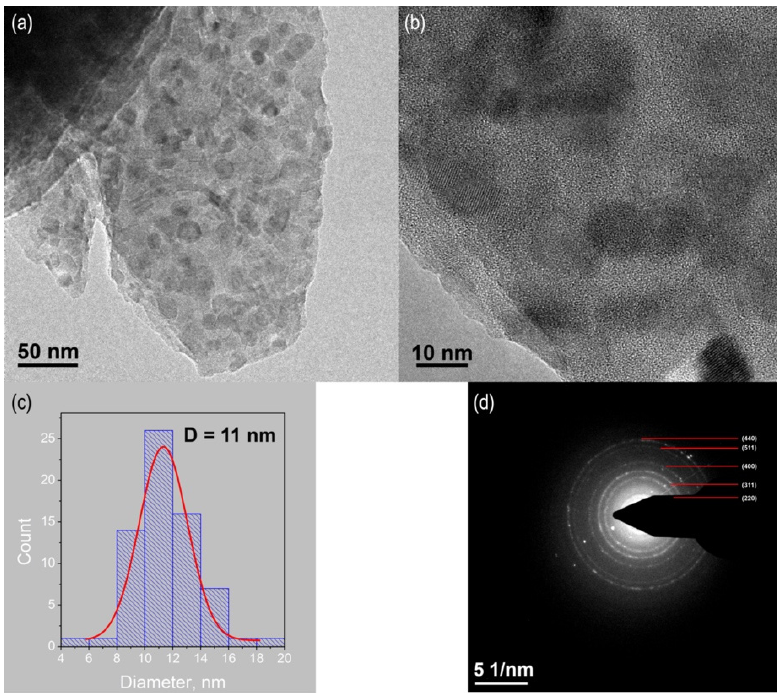
Figure 7. ( a ) TEM and ( b ) HRTEM images of the Au-doped glass sample heat treated at 950 °C for 20 h. ( c ) the size distribution of nanocrystals and ( d ) corresponding SAED patterns of the area in ( b ).